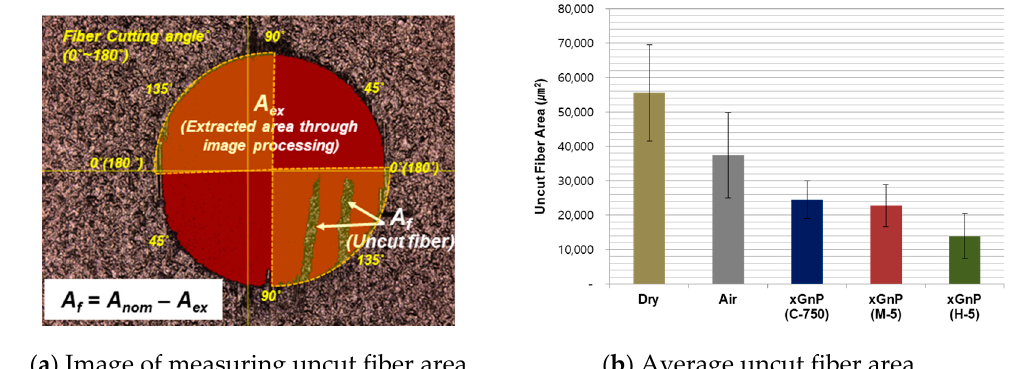
Figure 11. Sample images for measuring uncut fiber and average uncut fiber area.